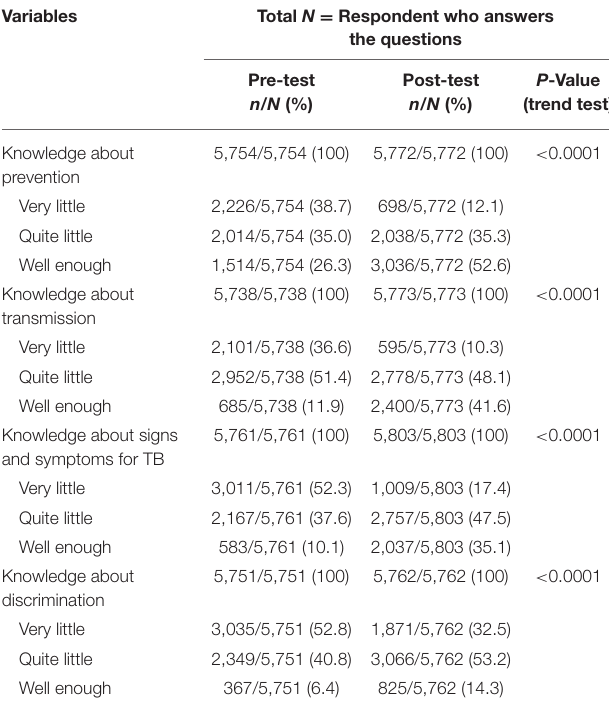
TABLE 2 | Self-perceived knowledge of TB by pre- and post-film screening.